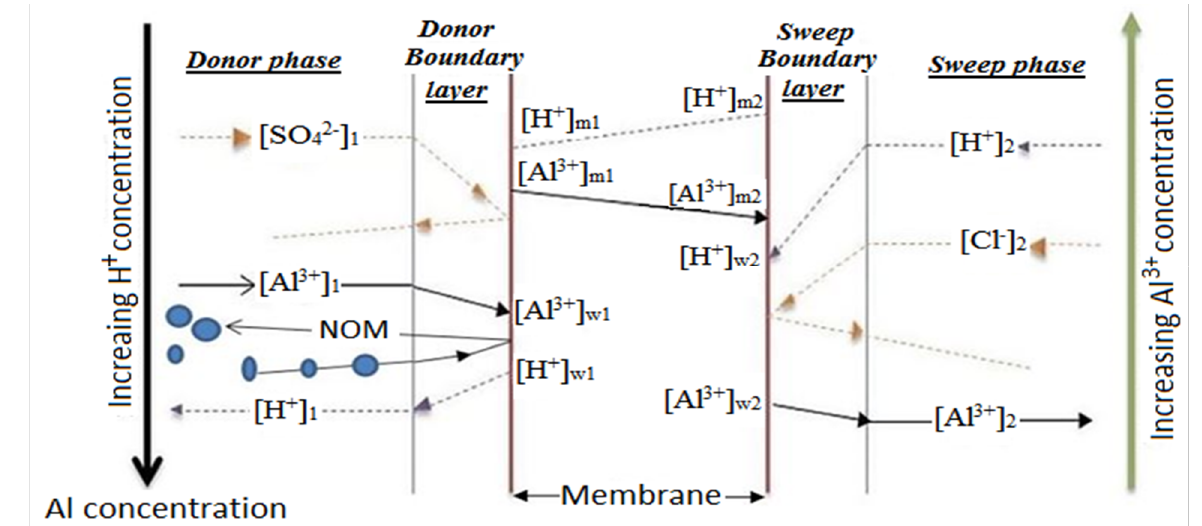
Figure 4. Al 3+ -H + transport through a cation exchange membrane.